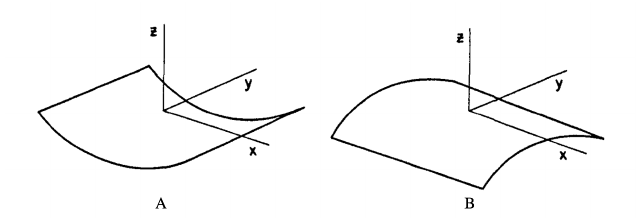
Figure 1. Cylindrical shape ( A ) and cylindrical shape of opposite sign and perpendicular axes of curvature ( B )